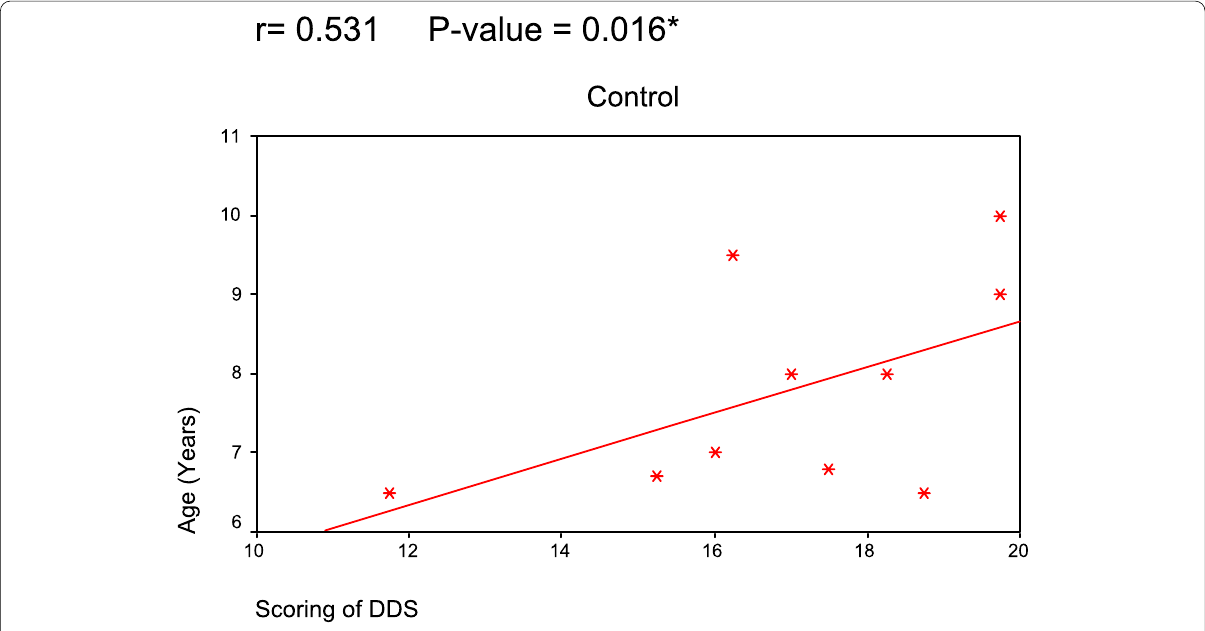
Fig. 2 Correlation between age and total score of DDS in control children